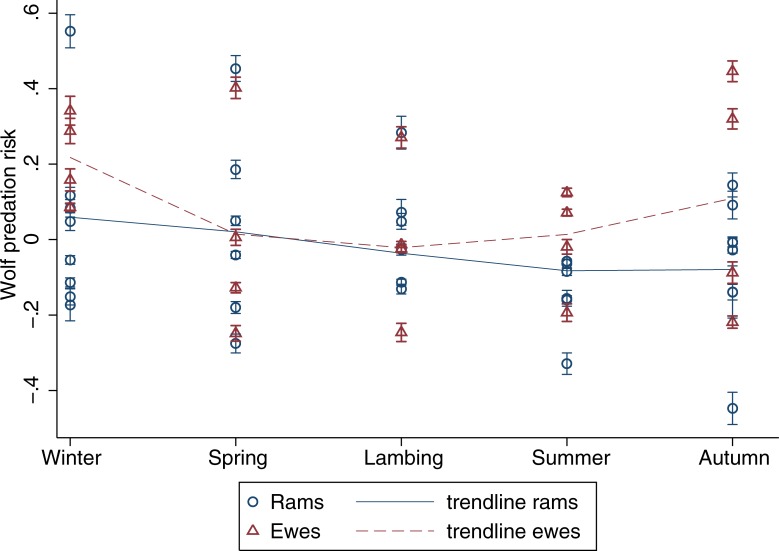
Regression coefficients representing seasonal exposure to wolf predation risk for Dall sheep rams and ewes, calculated from the composite seasonal home range of all collared wolves within the study area.Error bars on each data point correspond to the 95% confidence interval. A fractional polynomial trendline for rams and ewes is shown.